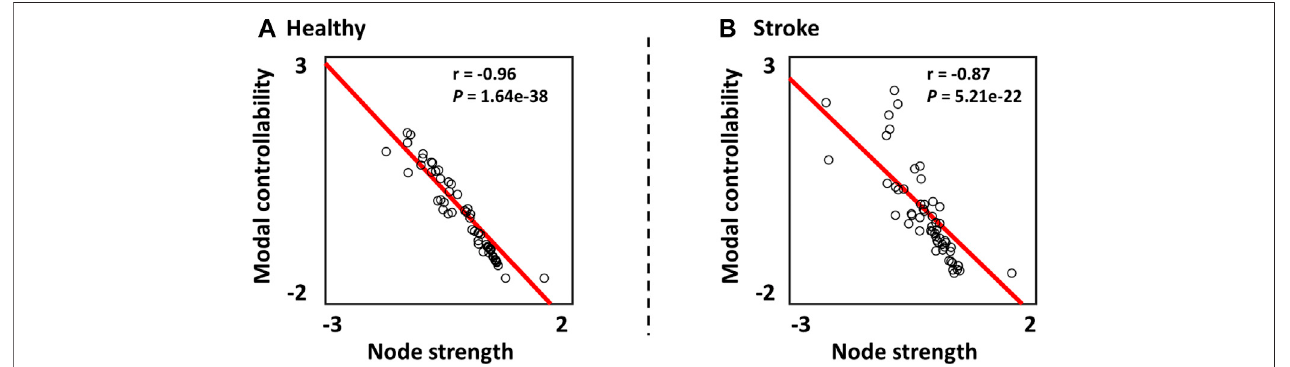
FIGURE 3 | Relationship between the z-scored modal controllability and the z-scored node strength in (A) Healthy subjects and (B) Stroke patients.